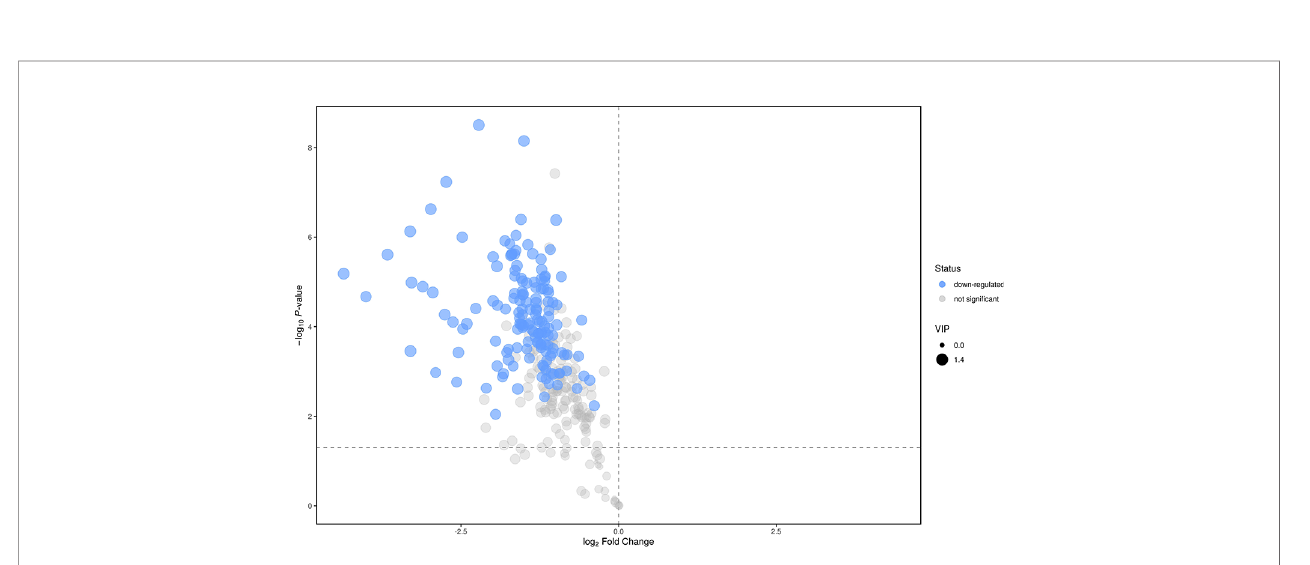
FIGURE 2 | Volcano plot for the treatment (KS) vs control (HC) groups.